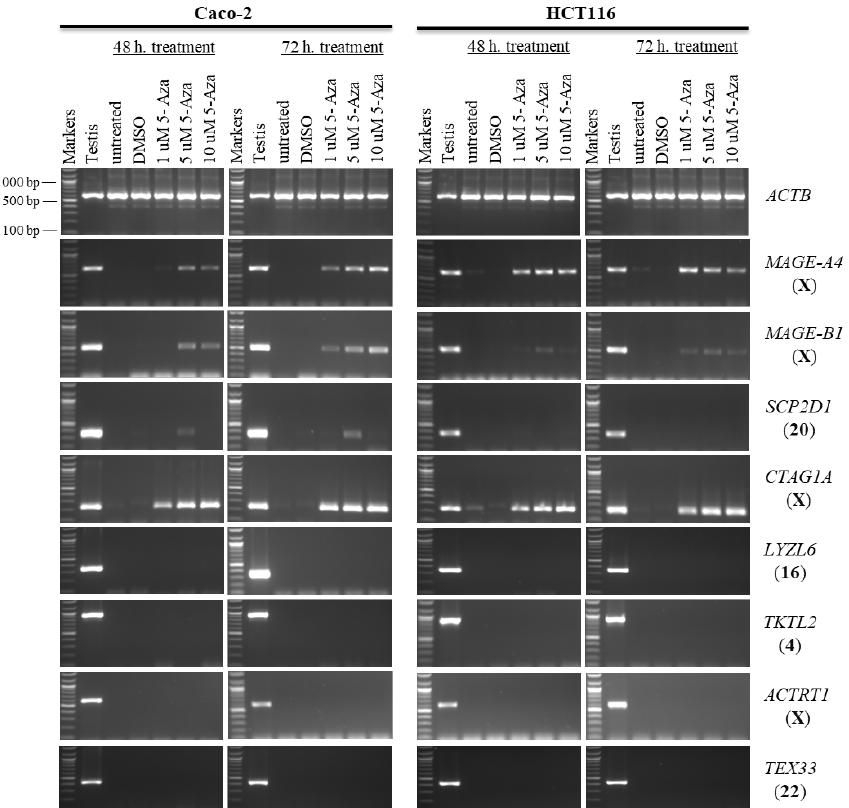
Figure 1. The effects of 5-aza-CdR treatments on CT gene expression profiles in the Caco-2 and HCT116 cancer cell lines. The expression of SCP2D1 , CTAG1A , LYZL6 , TKTL2 , ACTRT1 , and TEX33 genes is shown on agarose gels following treatment with various doses of 5-aza-CdR for 48 h (left column of each cell) or 72 h (right column of each cell). Untreated Caco-2 and HCT116 cells were utilized as controls to compare the expression of CT genes with treated cells, and a testis sample served as a positive control for primer efficiency. The control Caco-2 and HCT116 cells were treated with DMSO, as DMSO was the solvent used in the 5-aza-CdR solution. The positive control for the cDNA samples is the expression of the ACTB gene. The official names of the genes are written to the right of the agarose gel images, and the location of each gene on the chromosomal is written in parentheses on the right. Above each lane, the particular concentration of 5-aza-CdR (1, 5, and 10 µ M) is